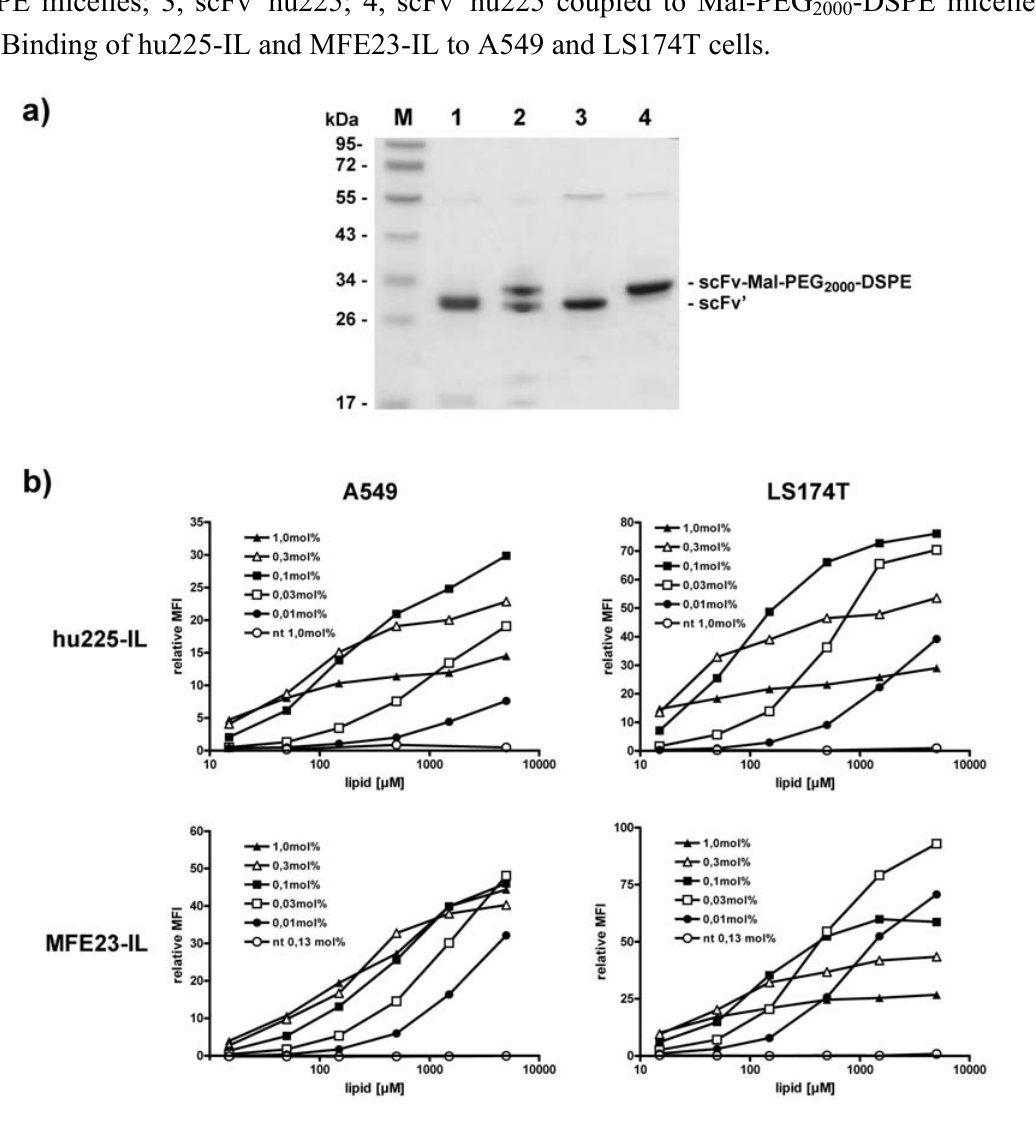
-DSPE was analyzed by SDS-PAGE 2000 - 2000 -DSPE micelles; 2000